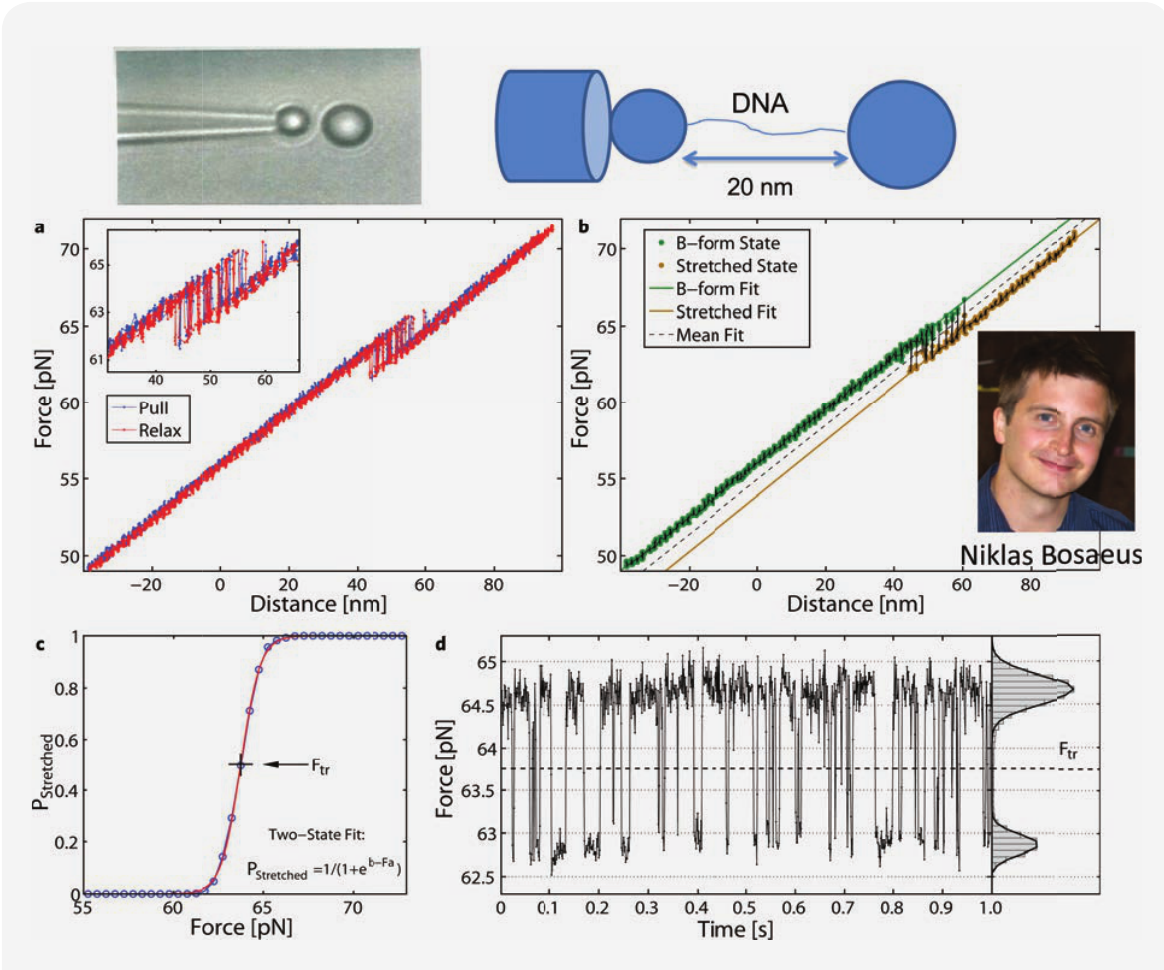
Figure 12. Discovery by Dr Niklas Bosaeus of a 51% elongated DNA conformation, by laser-tweezers stretching. Bistability noticed at 63 pN applied force along the 3 ′ -3 ′ strands. A 60 base-pair long duplex DNA applied between latex beads, one bead in laser trap and one at a pipette. No reaction with glyoxal in stretched state proves that base-pairs remain intact. Figure adapted from results by Bosaeus et al.